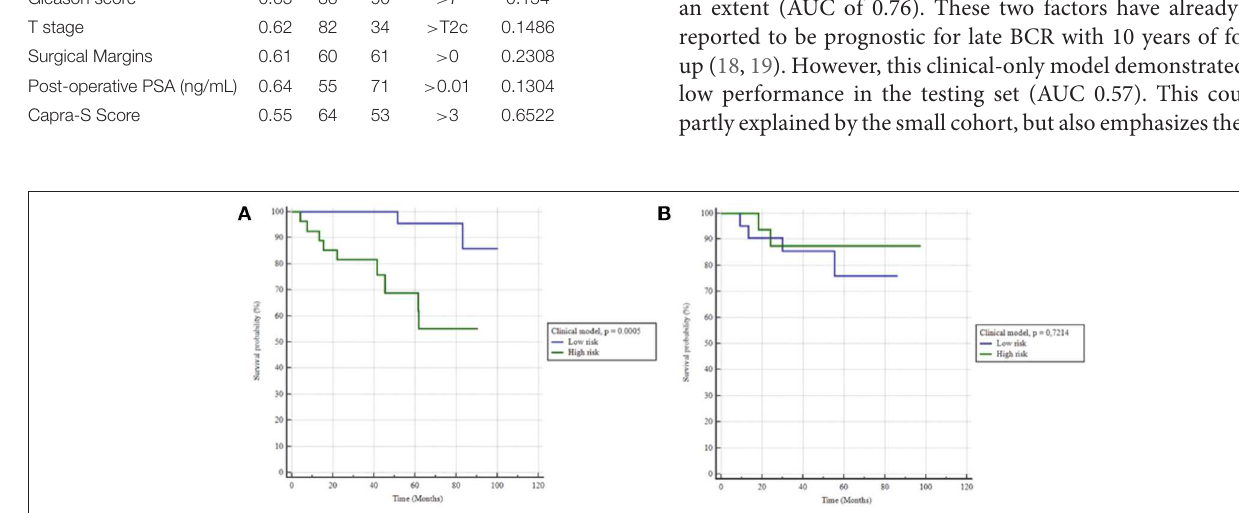
FIGURE 2 | Kaplan-Meier estimates of biochemical relapse free survival using the clinical model for (A) training and (B) testing set.